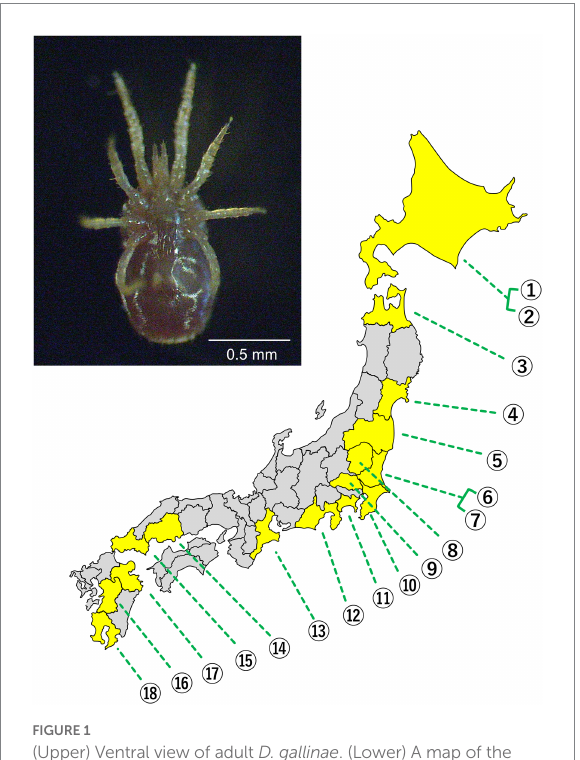
FIGURE 1 (Upper) Ventral view of adult D. gallinae . (Lower) A map of the Japanese archipelago. Prefectures where the mites were sampled are depicted in yellow. Each number represents a poultry farm. The exact location of each poultry farm is